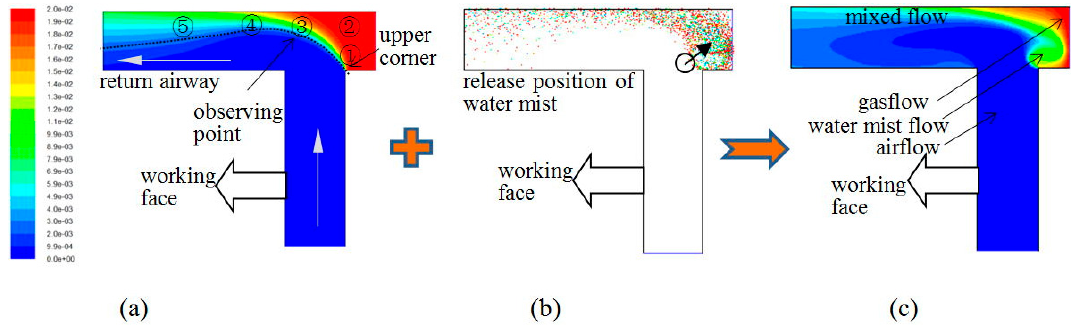
Figure 14. Release of water mist in the upper-corner: ( a ) gas flow field, ( b ) water mist flow field, and ( c ) the stacking of flow fields around the water mist and gas. Energies 2017 , 10 , 1566 12 of 14